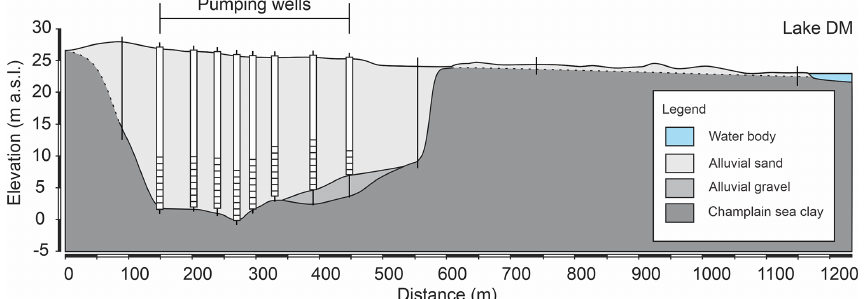
Figure A1. Geological cross section along the pumping wells showing the buried valley carved into the Champlain Sea clays and filled with alluvial gravels and